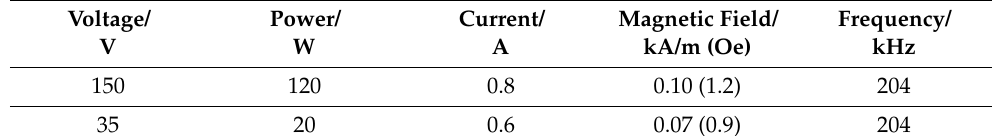
Table 7. Experimental parameters for induction heating investigations.